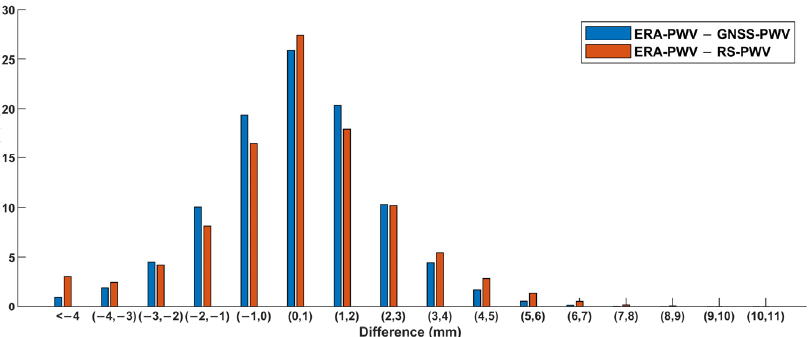
Figure 4. Distribution of the differences (in millimeters) between GNSS-PWV, RS-PWV, and ERA- PWV in the six-year period studied from 2013 to 2018 over China.